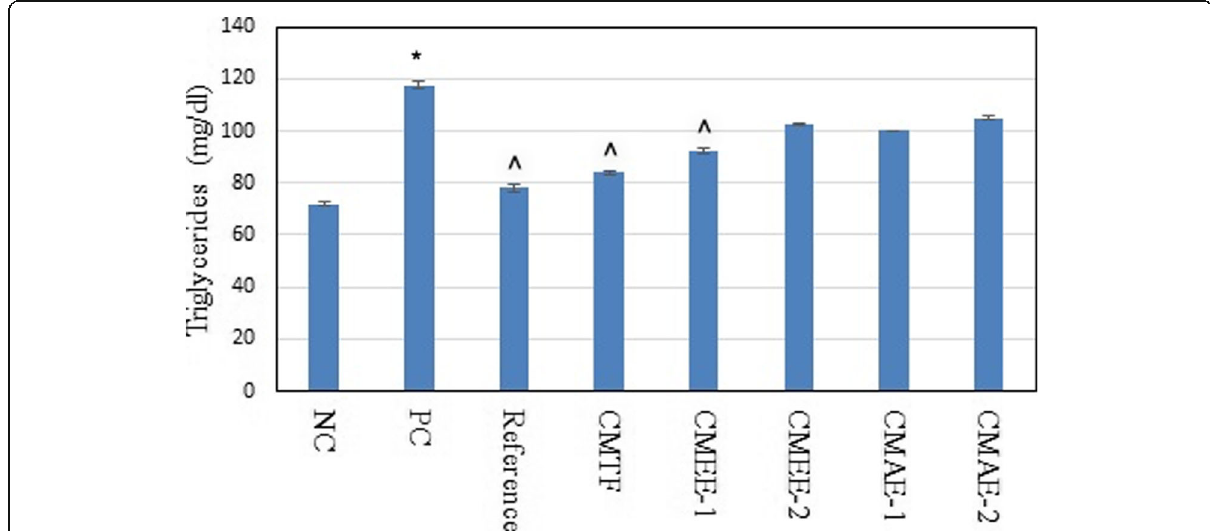
Fig. 2 Effect of C. melo fraction and extracts on the TG level of animals. Values are expressed as mean ± standard error of mean ( n = 6), significantly different at * P < 0.05, vs the normal control group; △ P < 0.05, vs the diabetic control group analyzed by one-way ANOVA followed by Tukey ’ s multiple comparison test. CMTF, Cucumis melo toluene fraction (ethanolic extract); CMEE 1, Cucumis melo ethanolic extract (400 mg/kg); CMEE 2, Cucumis melo ethanolic extract (200 mg/kg); CMAE, Cucumis melo aqueous extract (400 mg/kg); CMAE, Cucumis melo aqueous